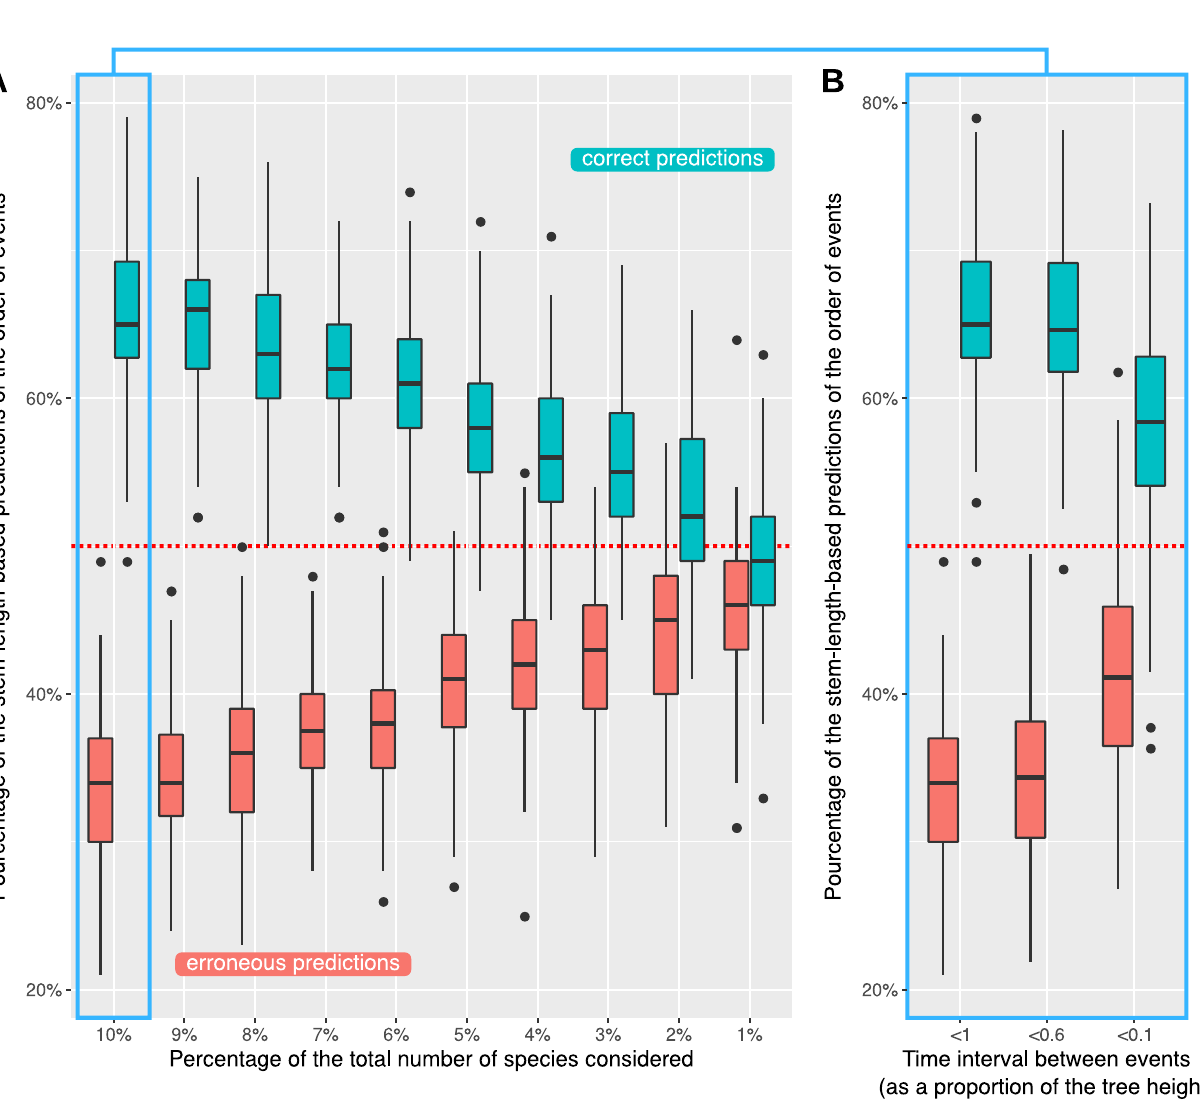
Fig 6. Impact of sampling on the stem-length method. Effect of the proportion of species sampled ( A ) and the length of the time interval between acquisition events ( B ) on the percentage of right (blue bars) and wrong (red bars) predictions of the order of events using the stem-length method. The dashed red line represents what would be observed if predictions were random. Cases where the stem-length method could not order events (because stems had the same length) were removed, which explains why the blue and red bars do not add up to 100%. Data underlying this figure can be found on Zenodo (doi: 10.5281/ zenodo.6901799) and GitHub